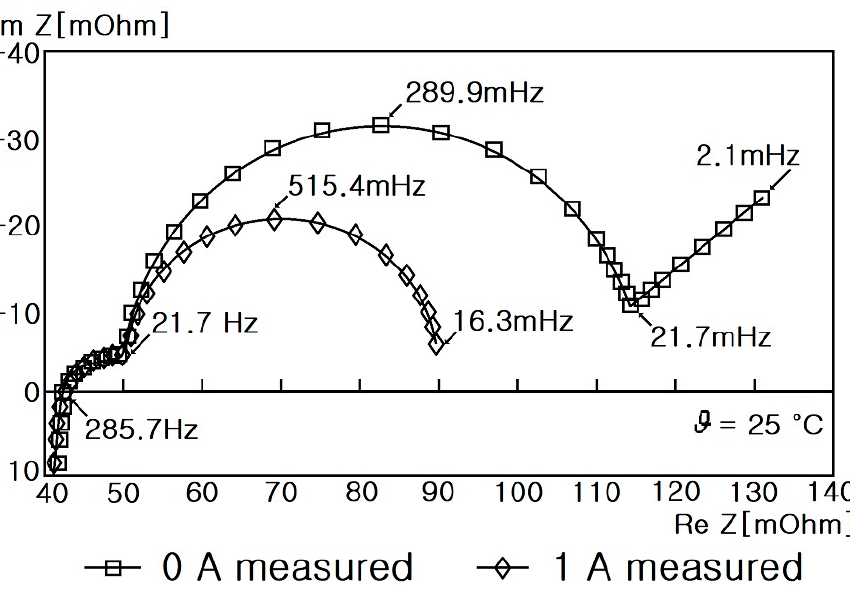
Figure 7. Impedance spectrum according to the presence or absence of charging for a cylindrical Li-ion battery[5].